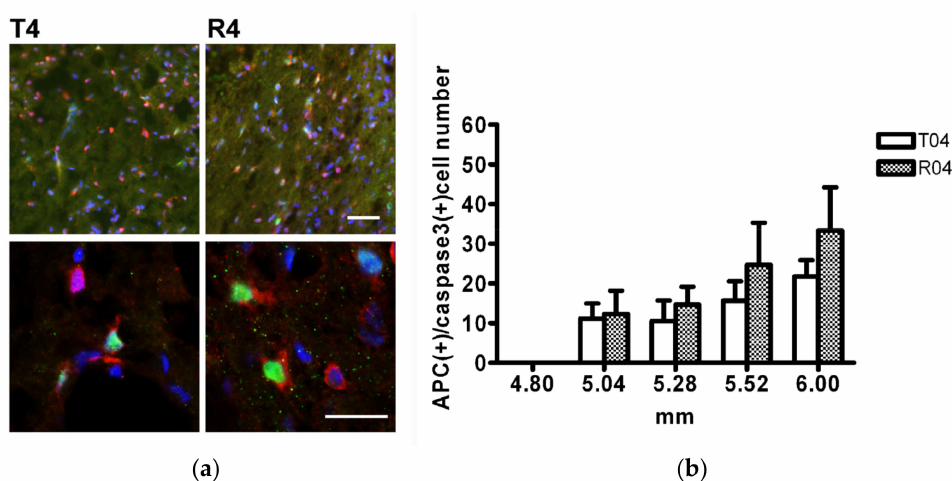
Figure 11. ( a ) The APC+ caspase+ cells of the dorsal funiculus at 5.5 mm distance from the trauma center. Double staining using APC and caspase-3 was used to detect apoptotic oligodendrocytes. Lower panel is a high magnification of the upper panel. Animal number used: T4 ( n = 5) R4 ( n = 3). ( b ) At 4.8 mm to 6 mm from the trauma center, the number of cells double stained with APC and caspase-3 was not different. Pairwise t -test. Animal number used: T4 ( n = 5) R4 ( n = 3). Upper scale bar = 50 µ m. Lower scale bar = 10 µ